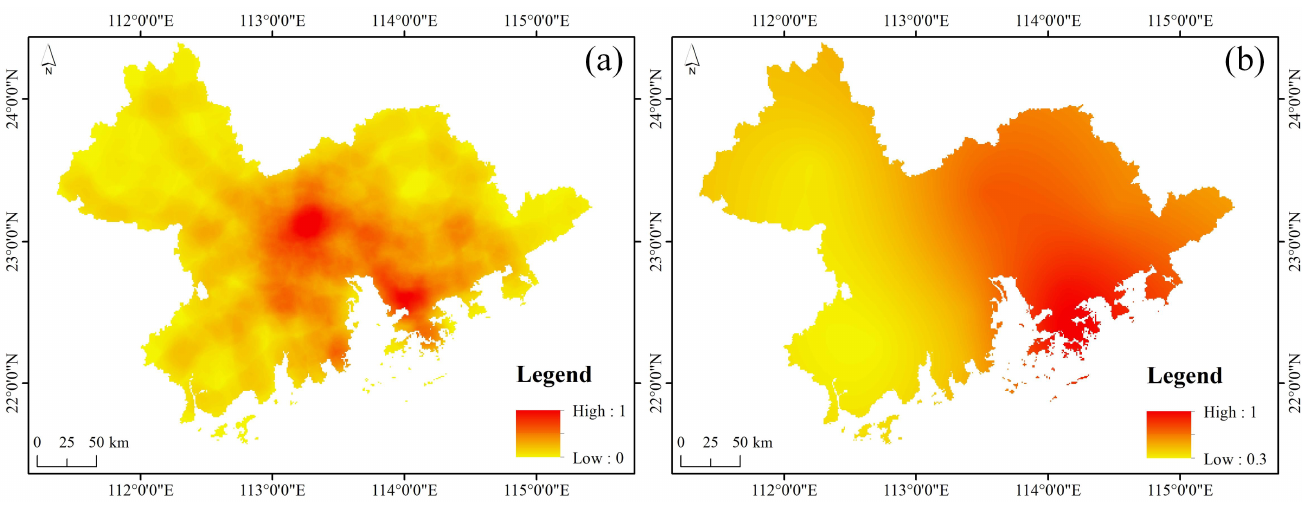
Figure 10. The spatial distribution of normalized accessibility ( a ) and ELI ( b ).